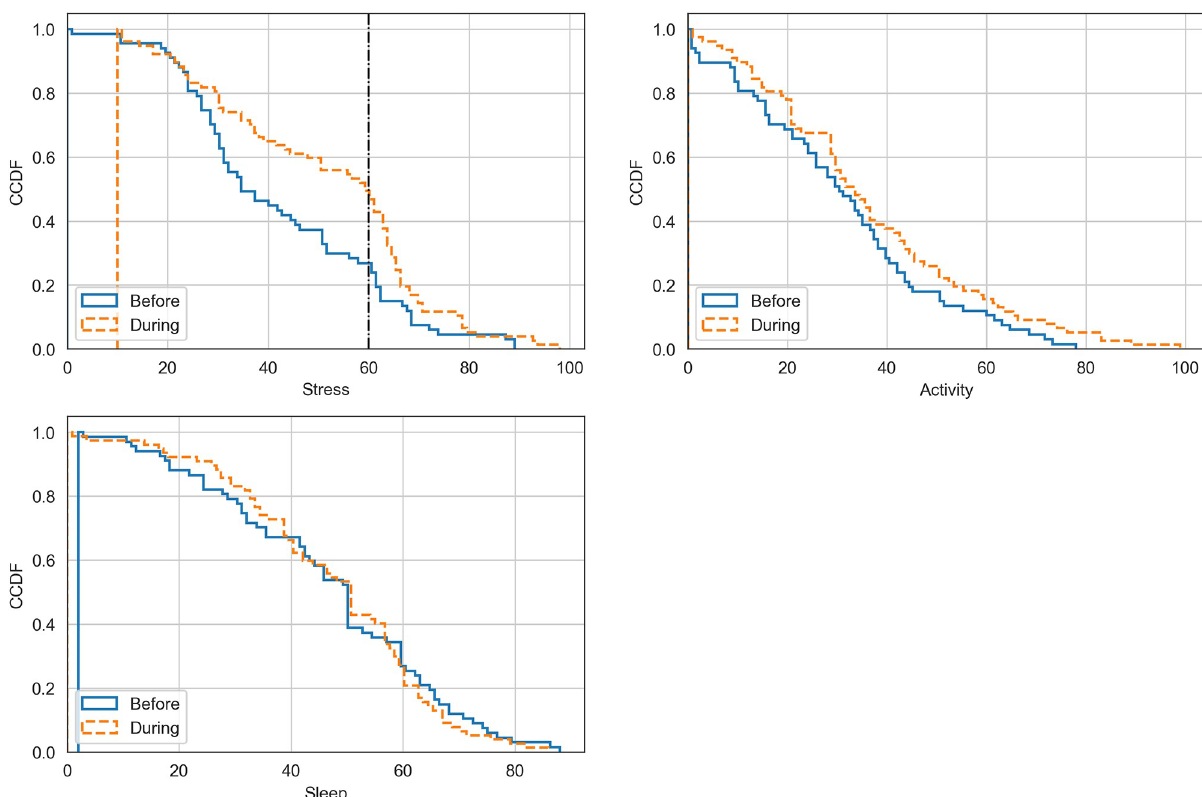
Fig 3. Subjective evaluations of stress, physical activity and sleep. Participants’ (n = 23) subjectively assessed level of stress, level of physical activity and quality of sleep before and during the pandemic-related restrictions in a scale from 0 to 100 the higher value indicating a higher level of stress, higher level of physical activity and better quality of